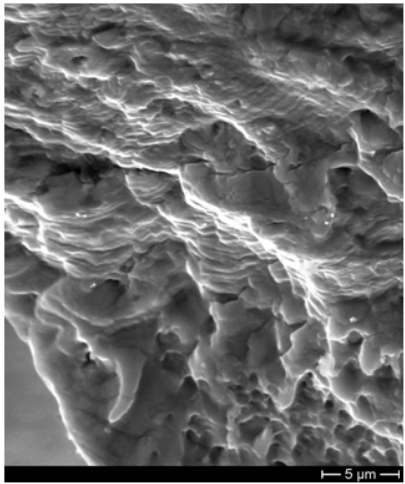
Figure 13: Fracture surface – dimples. Figure 14: Fracture surface – striations.